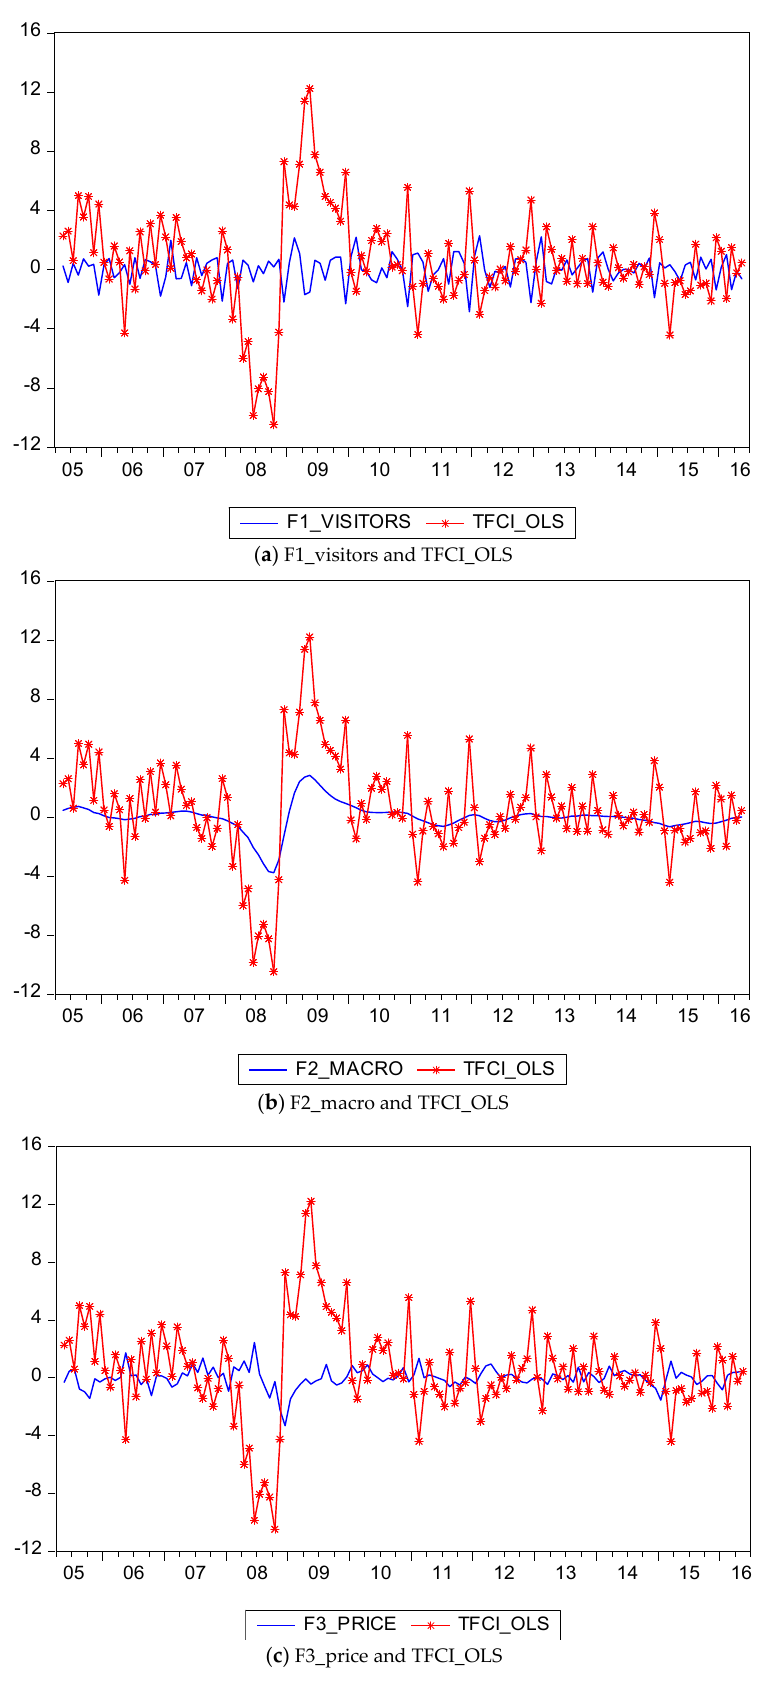
Figure 4. Time series for factors and TFCI (April 2005–June 2016).